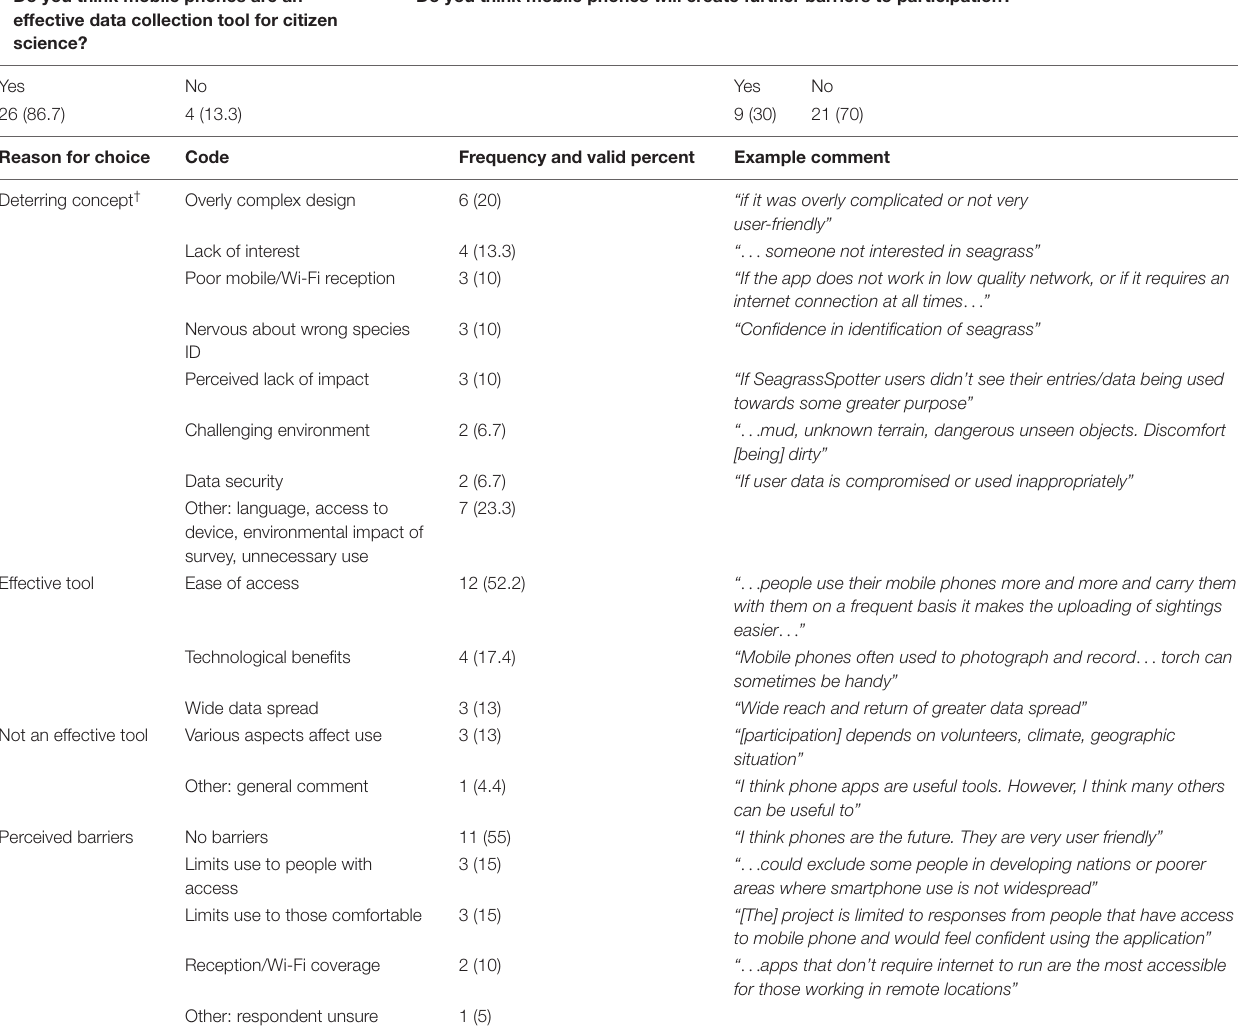
TABLE 8 | Perceptions of mobile phones as data collection tools by current SeagrassSpotter users. Do you think mobile phones are an effective data collection tool for citizen